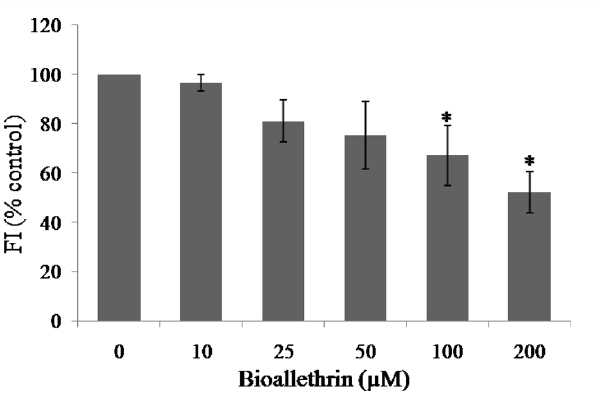
Figure 7. Effect of bioallethrin on mitochondrial membrane potential. Bioallethrin treated and control cells were mixed with Rhodamine 123 dye and fluorescence of samples recorded. Results are shown as percent control, taking fluorescence of control sample as 100%. Lymphocytes were incubated with bioallethrin for 2 h at 37 °C. Results are ± standard deviation of six different samples. *Significantly different from control at p < 0.05. FI fluorescence intensity (arbitrary